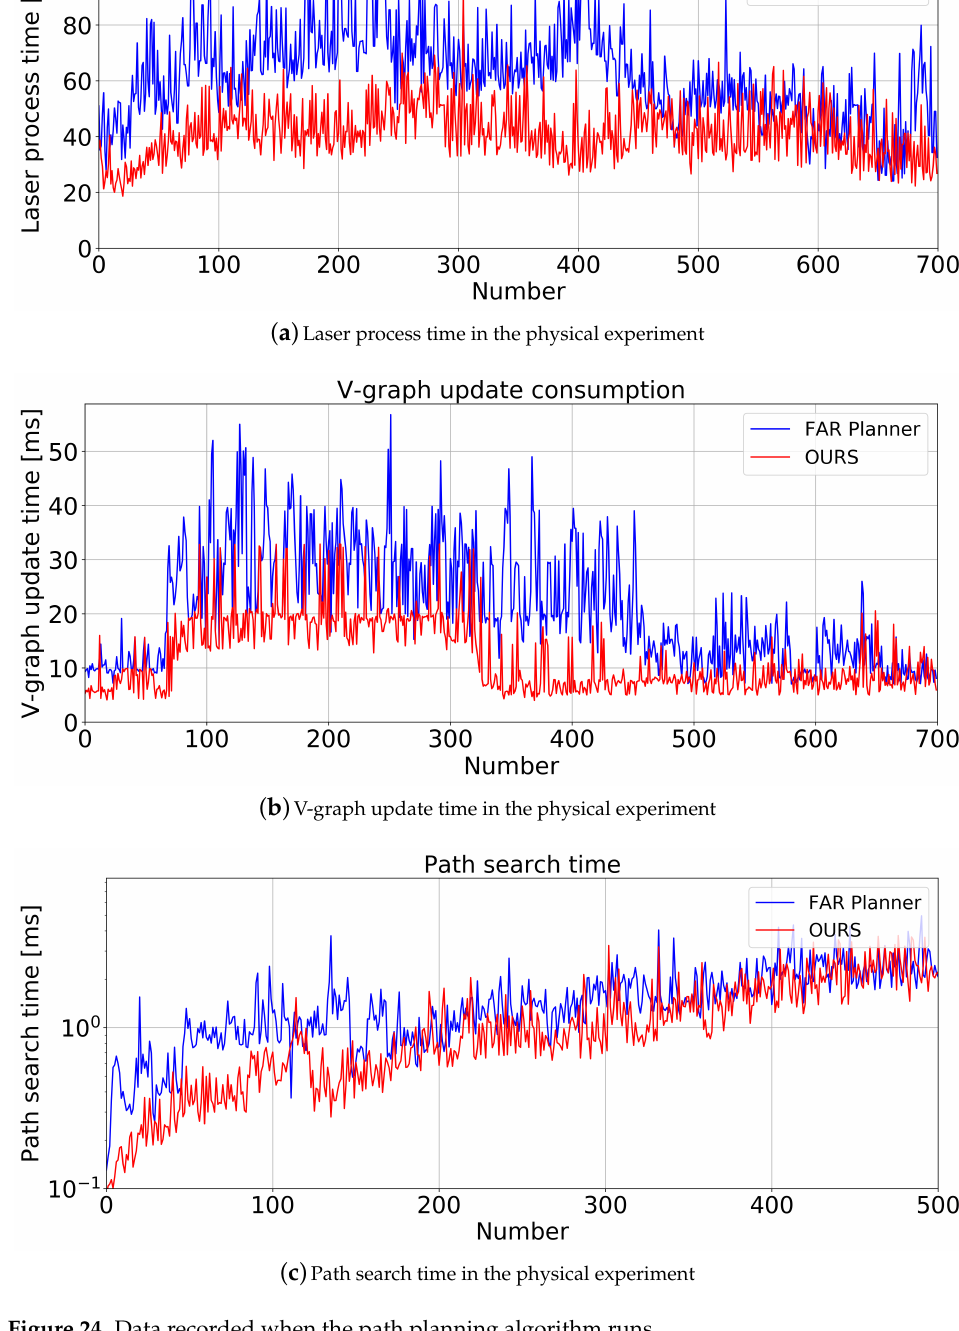
Figure 24. Data recorded when the path planning algorithm